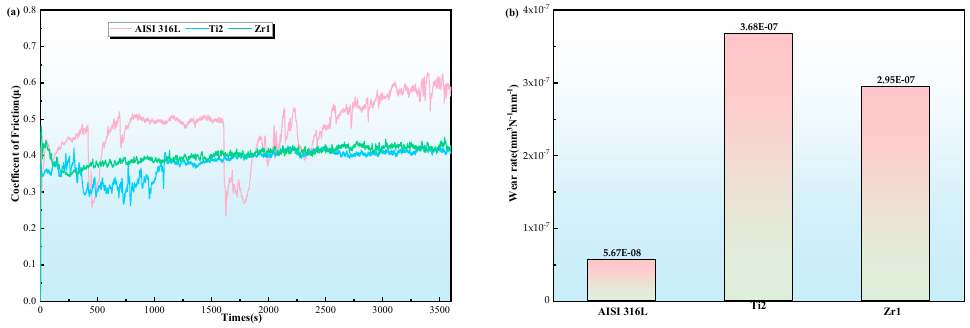
Figure 12. ( a )Friction factor and ( b )wear rate of specimens under dry friction conditions